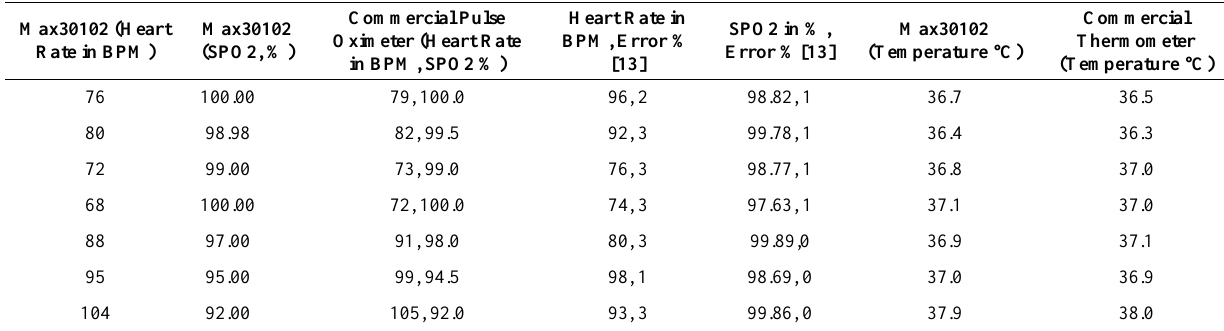
Table 1. Comparison between the current research results and findings from previous work and other commercial pulse oximeters and